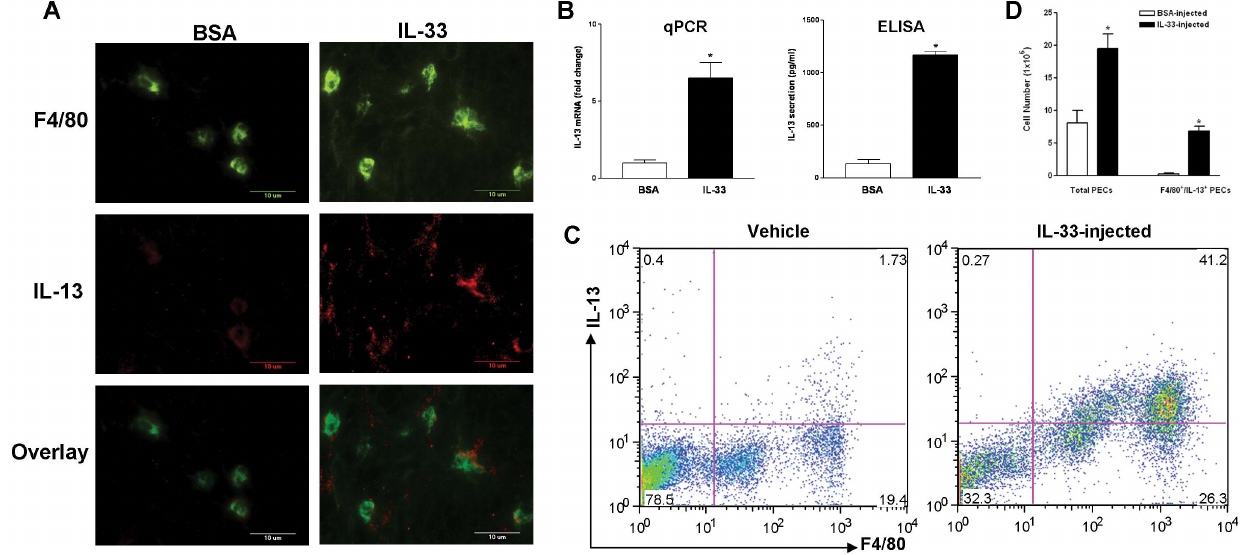
Figure 4. Exogenously administrated IL-33 in mice induced IL-13-expressing macrophages. C57BL/6 mice were i.p. injected with BSA or IL-33 (1 m g/mouse) daily for 3 days. A, Sections of small intestine were stained with anti-F4/80 (green) and anti-IL-13 (red). Representative images from 5 animals per group were shown. B, Peritoneal exudate cells (PECs) were collected and analyzed for IL-13 expression by qPCR or ELISA in triplicates (n=3–5 per group, *p , 0.05 vs respective BSA, t test). C, Representative plots from PECs stained with anti-F4/80 and anti-IL-13 for analyzing IL-13-expressing macrophages by FACS. D, Number of total PECs and F4/80 + /IL-13 + PECs collected per mouse after injection of BSA or IL-33 (n=3–5 per group, *p , 0.05 vs respective BSA). Data shown in bar graphs are the mean 6 s.e.m and representative of at least two independent experiments with similar results.